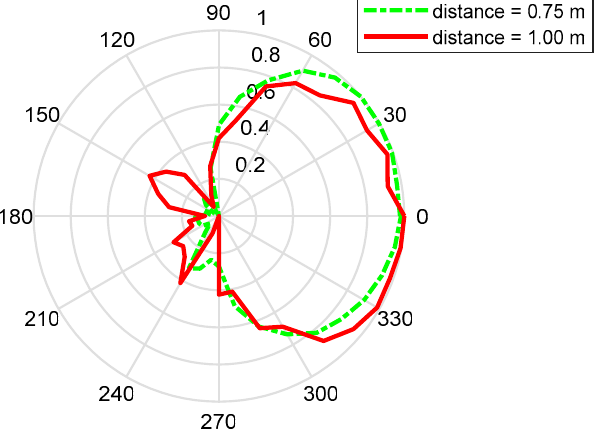
Figure 20. The measured and simulated results of E-plane (upon) and H-plane (below) and it can be found out that the measured back-lobe level at 1600 M at E-plane is considerably reduced as compared to 1150 M and 800 M.